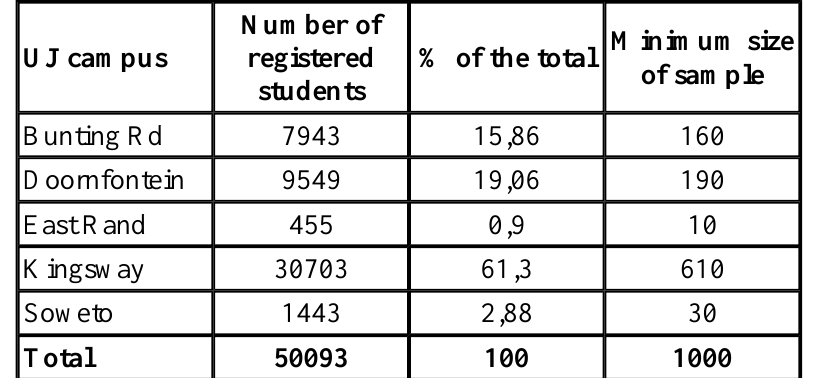
Table 1 Sample distribution among the different